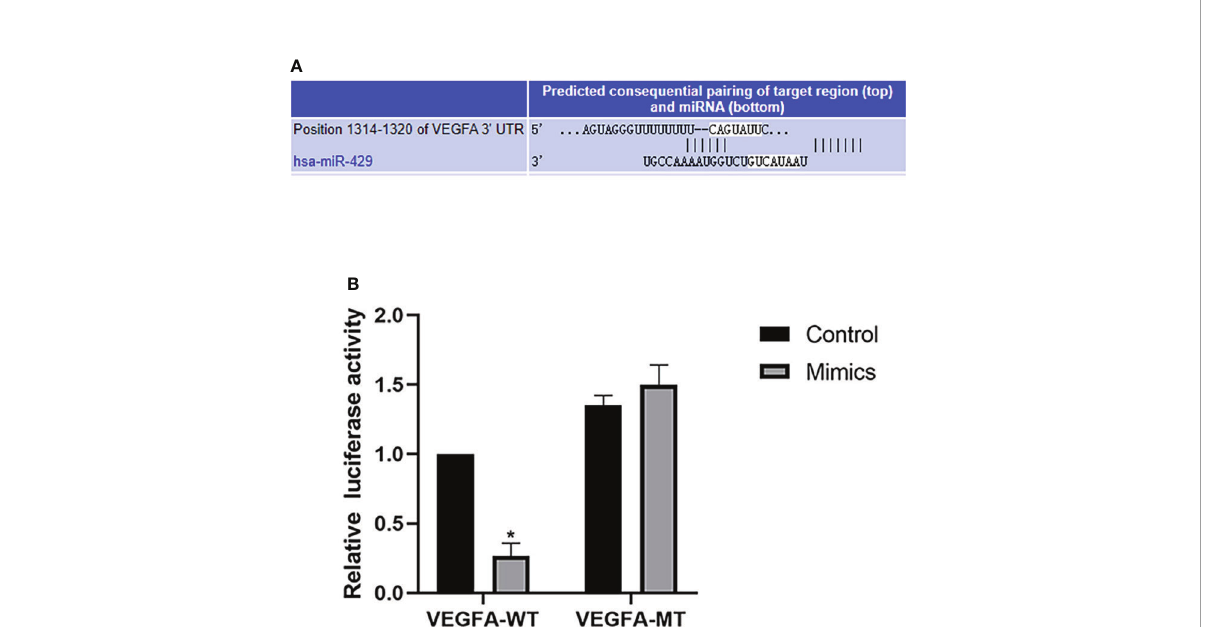
FIGURE 7 Bioinformatics analysis and dual luciferase reporter gene. (A) The binding site of VEGFA and miR-429 was identi fi ed with starBase v3.0. (B) Dual- luciferase assay results for RL95-2 cells transfected with wild-type (WT) or mutated (Mut) VEGFA reporters plus miR-429 mimic or mimic-NC molecules for 48 h. * P